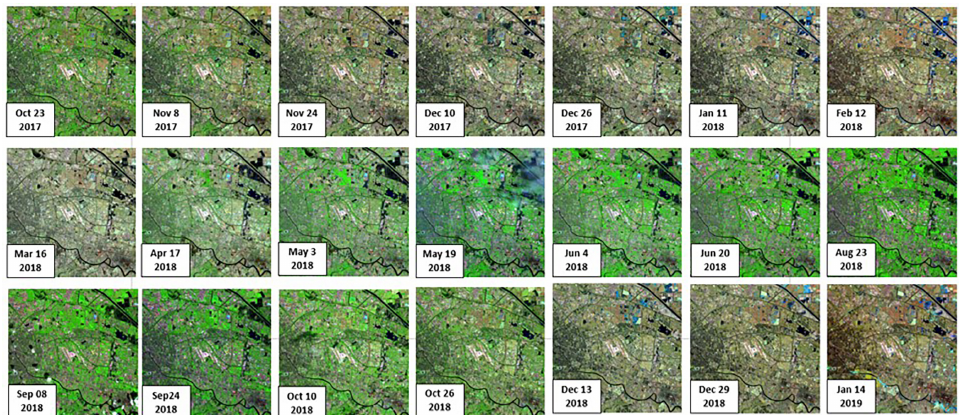
Figure 4. False-color composite image of SITS in the study area (R: B7, G: B5, B: B4). The Pearson correlation coefficient matrix of Landsat-8 SITS in the study area (Tianjin, China) from October 2017 to January 2019 is shown in Tables 1 and 2. The larger the Pearson Correlation Coefficient between different variables, the stronger the linear correlation of these variables, and vice versa. Table 1 shows that the range of Pearson Correlation Coefficient between images both acquired from October 2017 to December 2017 ranges from 0.71~1.00, and the average value is 0.88, indicating that a strong positive linear correlation exists between images with close acquisition times. Table 2 shows that the range of Pearson Correlation Coefficient between images acquired from October 2017 to December 2017 and images acquired from October 2018 to December 2018 is 0.61~0.75, and the average value is 0.67, indicating that the linear correlation between images which acquisition time is far apart is weak. Due to both linear and nonlinear radiation distortions existing between images in SITS in this area, the use of SITS in this area is more beneficial for testing the effectiveness of NMAG model. Table 1. The Pearson correlation coefficients between images both acquired from October 2017 to